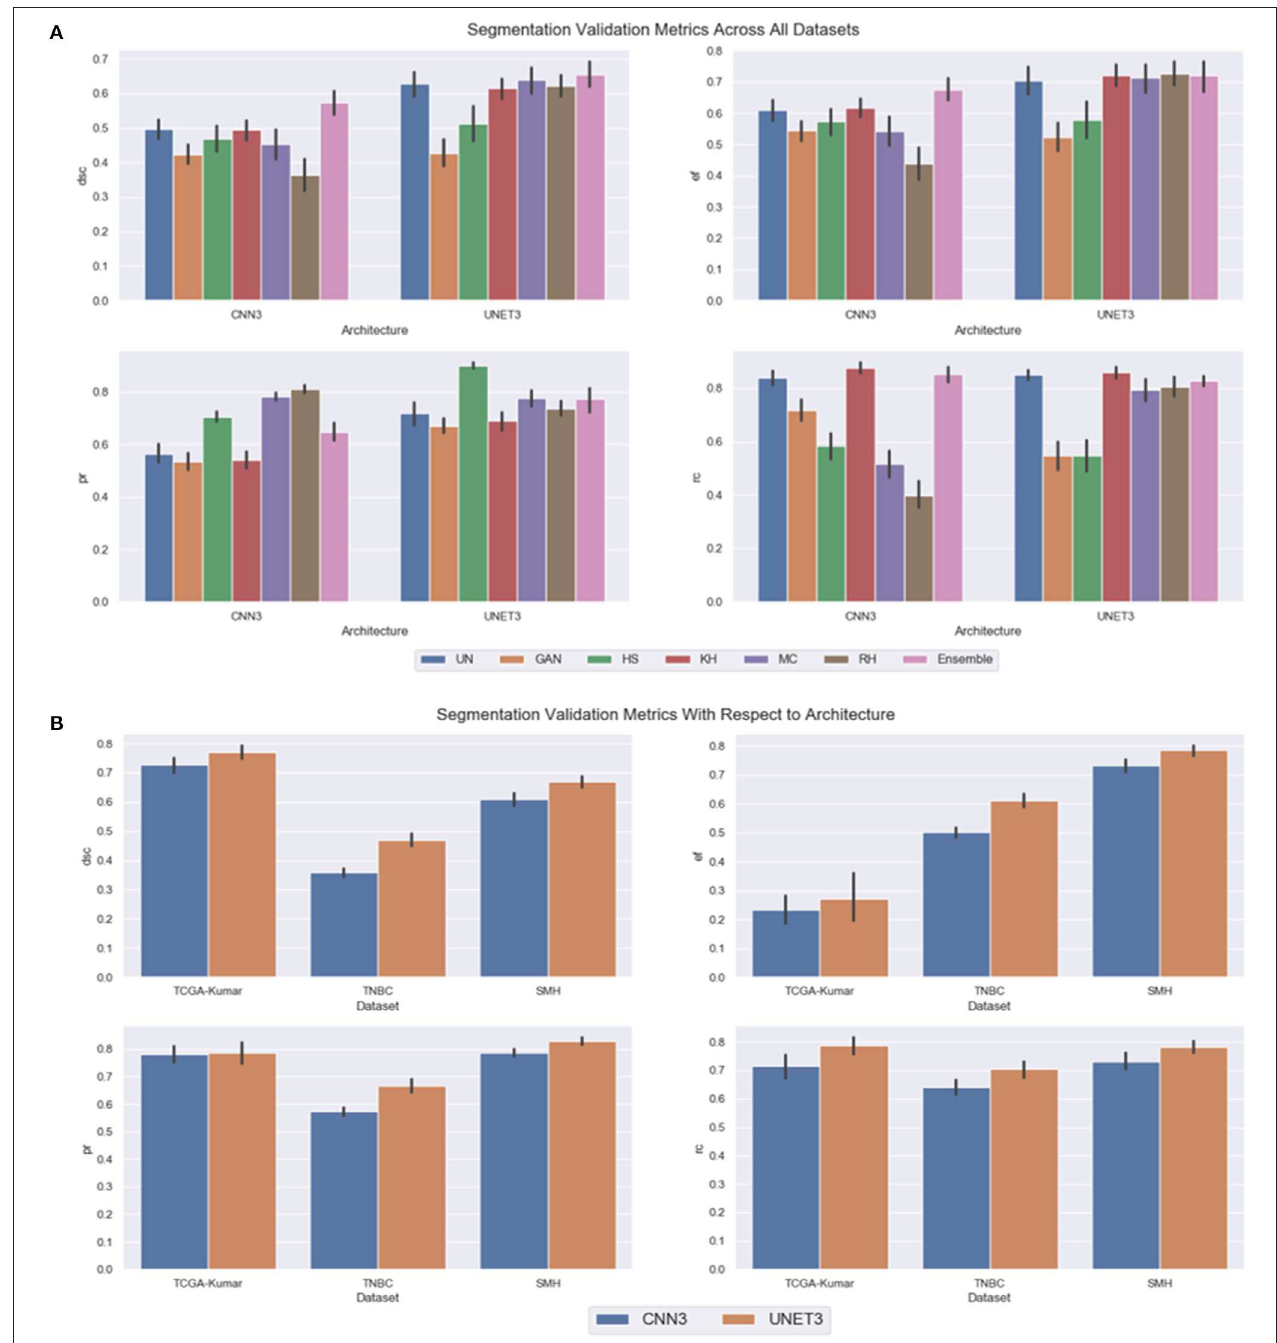
FIGURE 11 | Segmentation validation metrics across all datasets, (A) CN model as a function of architecture (B) dataset as a function of CNN model.